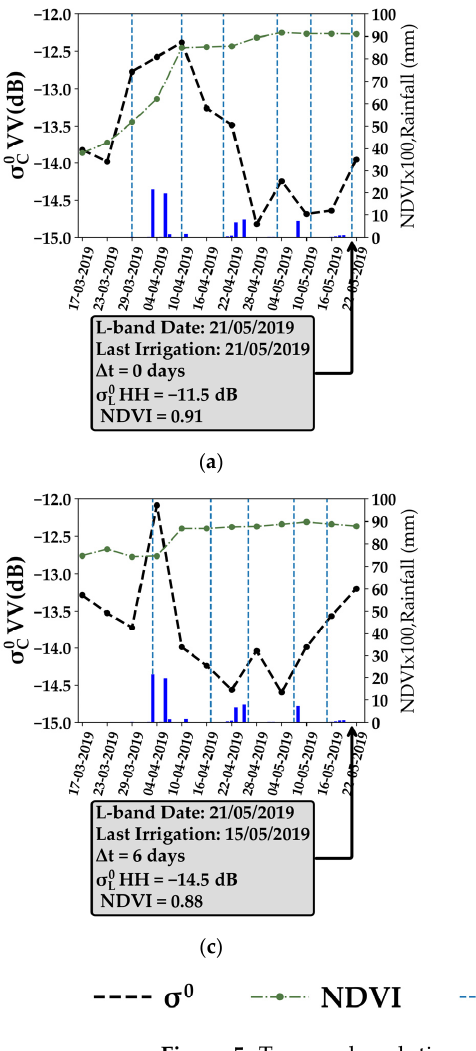
Figure 5. Temporal evolution of the S1 C-band SAR backscattering for 4 different grassland plots during the first growth cycle between March and May 2019. The green dotted line represents the S2 NDVI values multiplied by 100. The dashed blue lines represents the irrigation events and the solid blue bars represent the rainfall amounts. The grey boxes show the σ 0 values derived from the ALOS-2 image acquired on 21/05/2019 with the corresponding ∆ t value, the last irrigation date, and the NDVI value on 21/05/2019. ( a ) A1 at 44 ◦ , ( b ) A2 at 35 ◦ , ( c ) D2 at 42 ◦ , and ( d ) D1 at 32 ◦ For the grassland plot in Figure 5a, σ (cid:2887)(cid:2868) increased by 1.2 dB from − 13.9 to − 12.7 dB between 23/03 and 29/03 due to an irrigation event that occurred on 29/03 (the same day of the S1 acquisition). The NDVI value was relatively low on 29/03, reaching 0.52. The S1 signal then remained approximately stable at high values on 04/04, where the σ (cid:2887) (cid:2868) reached − 12.5 dB due to the rainfall event (21.4 mm) that occurred on 03/04. The second irrigation event that occurred on 10/04 (same day of the S1 image) caused σ (cid:2887)(cid:2868) to remain stable, reaching − 12.3 dB. The NDVI value on 10/04 was 0.84. This stability of σ (cid:2887)(cid:2868) at high levels, between 29/03 and 10/04, indicates the persistence of humid soil conditions between the 2 consecutive S1 images. Then, 6 days later on 16/04, the σ (cid:2887)(cid:2868) value decreased by 1 dB to